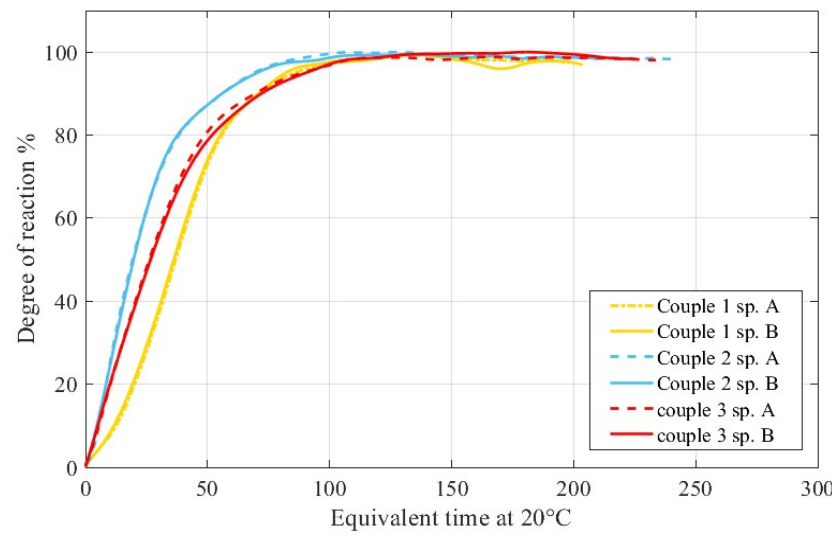
Figure 8. Comparison between Degree of reaction − Equivalent Time curves: OC-C37 series monitored in SAC. Series of the couple “2” where manufactured